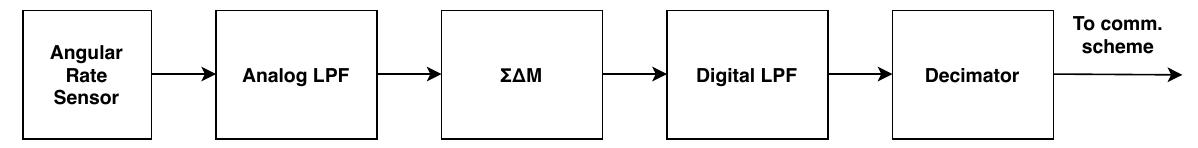
Figure 1. Block scheme of a 1-axis MEMS digital